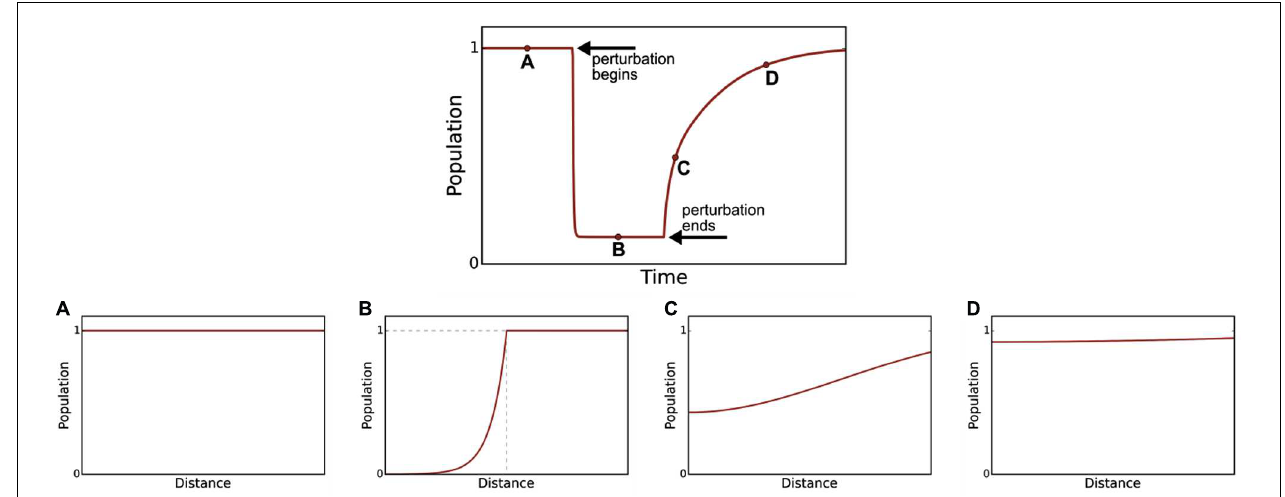
FIGURE 2 | Recovery over time is associated with recovery through the simulated microbial mat. The top profile shows the bulk population response of a species over time: before (A) , during (B) , and after (C,D) a step-change perturbation is applied. Bottom figures show the species spatial distribution at each time point. Before the perturbation (A) the species has a homogenous population density. During the perturbation (B) , with perturbation profile shown as dashed gray line), the population density is lowest in the perturbed region. After the perturbation has been removed, the species begins to recover (C) until its population density approaches the pre-perturbed profile (D)